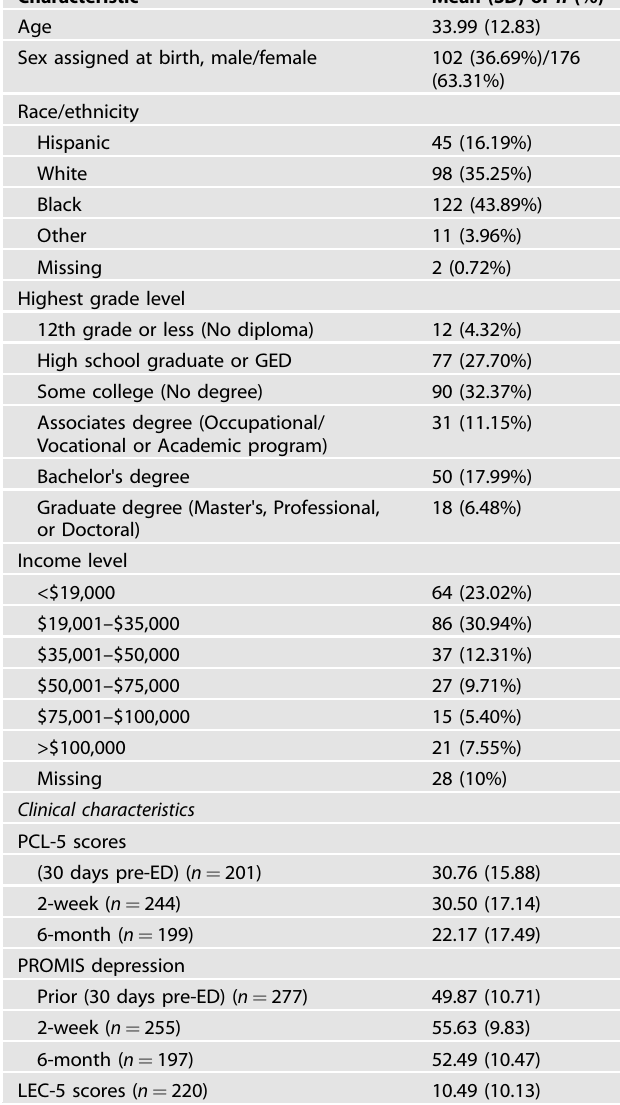
Magnetic resonance imaging General procedures . MRI data were collected across fi ve sites with harmonized acquisition parameters (Table S2). In the present analyses, we utilized participants ’ T1-weighted, DWI, task-fMRI during a threat